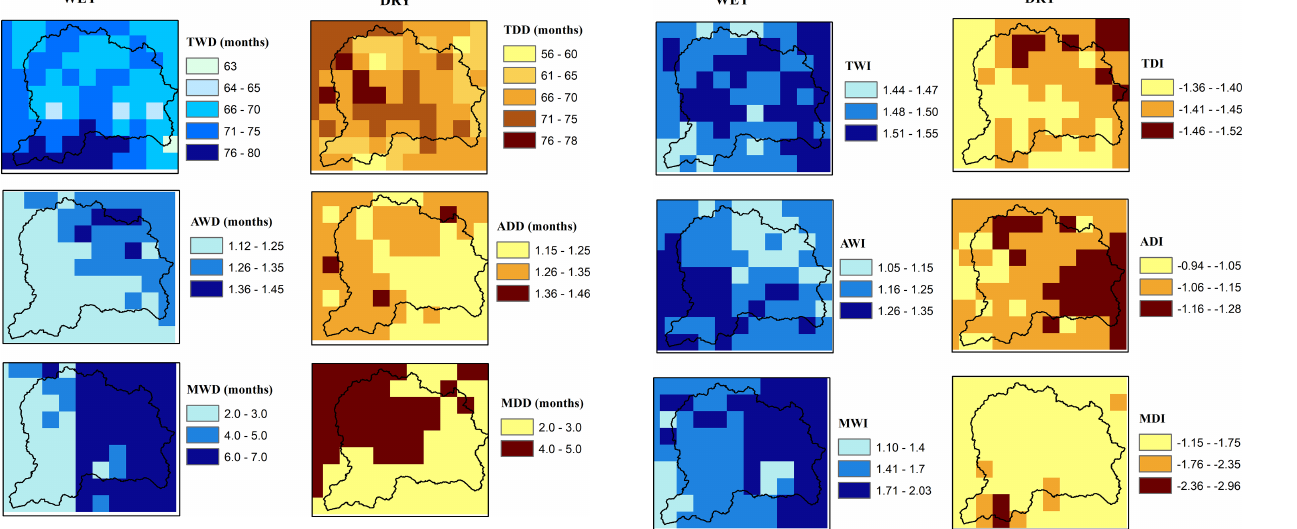
Figure 6. Spatial distribution of total wet intensity (TWI), total dry intensity (TDI), average wet intensity (AWI), average dry intensity (ADI), maximum wet intensity (MWI), and maximum dry intensity (MDI) for the period 1981–2014.